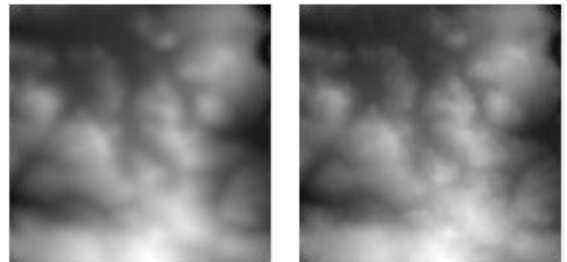
Figure 7. 25 m resolution DTMs: SoI (left) and SRTM (right) for area